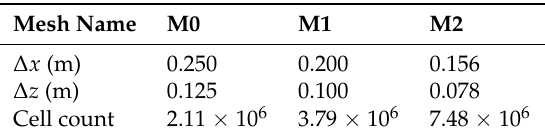
Table 3. The wave band cell sizes and the cell count of the three meshes used in the simulations. All meshes had aspect ratio ∆ x / ∆ z = 2 in the wave band. The cell count is for the narrower version of the wave tank. The wider mesh M2 cell count was 8.64 million